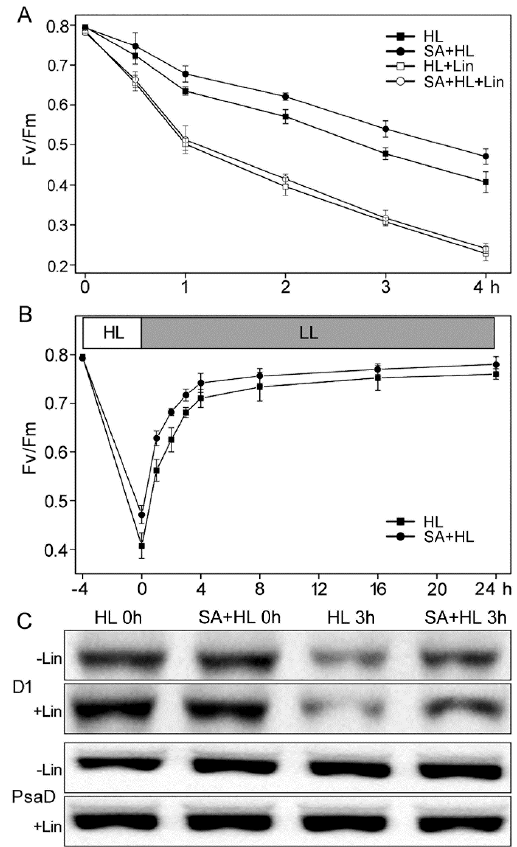
Figure 4. PSII photosensitivity of Arabidopsis thaliana in the presence or absence of SA pretreatment during high light illumination. ( A ) Untreated ( − ) and lincomycin ‐ treated (+) detached leaves were exposed to high ‐ light (HL) conditions (1000 μ mol photons m − 2 ∙ s − 1 ) for 4 h. ( B ) The photoinhibited detached leaves were recovered at low light (LL) intensity (10 μ mol photons m − 2 ∙ s − 1 ) up to 24 h with regular measurement of Fv/Fm. Values are means ± SD from three independent biological replicates ( n = 3). ( C ) Immunoblot analysis of thylakoid proteins obtained from Arabidopsis thaliana in the presence or absence of SA pretreatment with D1 and PsaD antibodies before ( − ) and after (+) photoinhibition using a light intensity of 1000 μ mol photons m − 2 ∙ s − 1 for 3 h. PsaD was as a loading control.